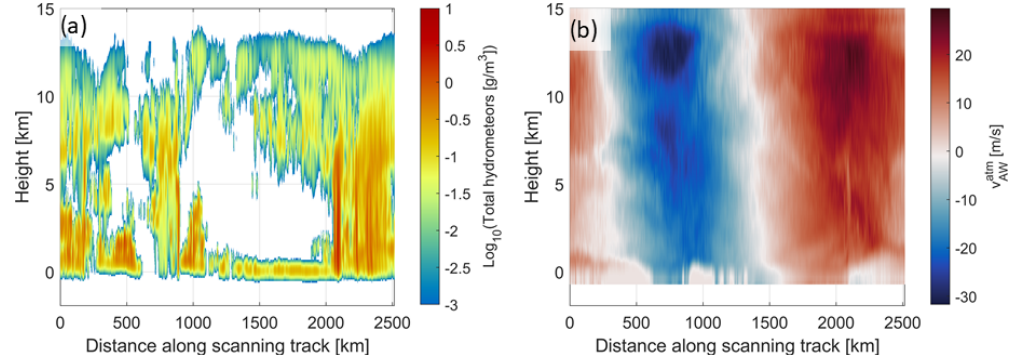
Figure 12. Antenna weighted hydrometeor content in grams per cubic meter (gm − 3 ) expressed in base 10 logarithmic scale (a) and LOS winds (b) in correspondence to the revolution shown in Fig. 9b. Only hydrometeor contents above 1mgm − 3 are shown. The change in velocity reflects the different antenna viewing directions of the weather